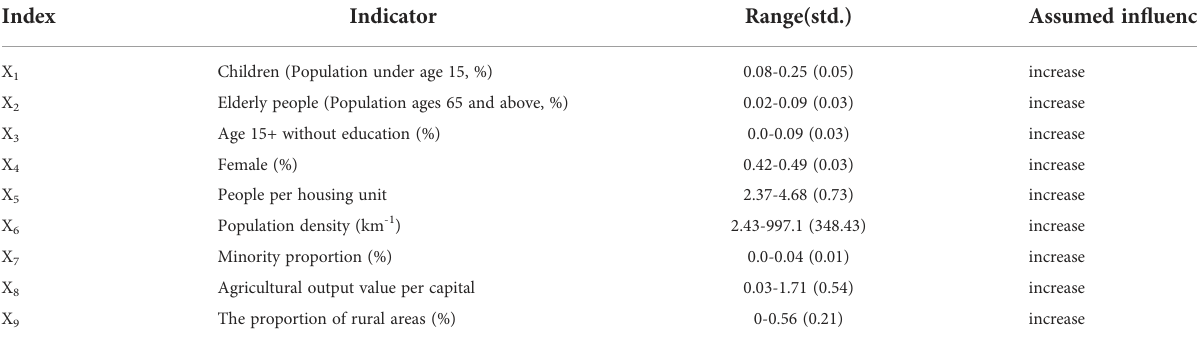
TABLE 2 Indicators utilized to assess social vulnerability in the study area.